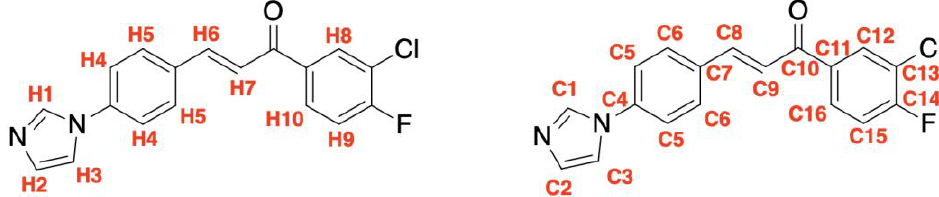
Figure 1. NMR assignment of chalcone 3 .